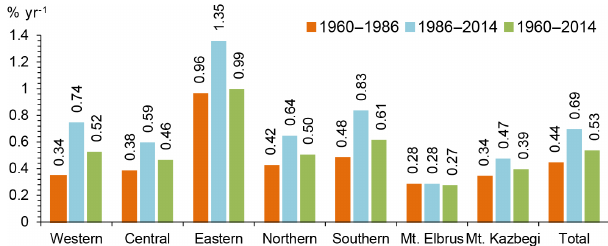
Figure 4. Greater Caucasus glacier area decrease by slopes,